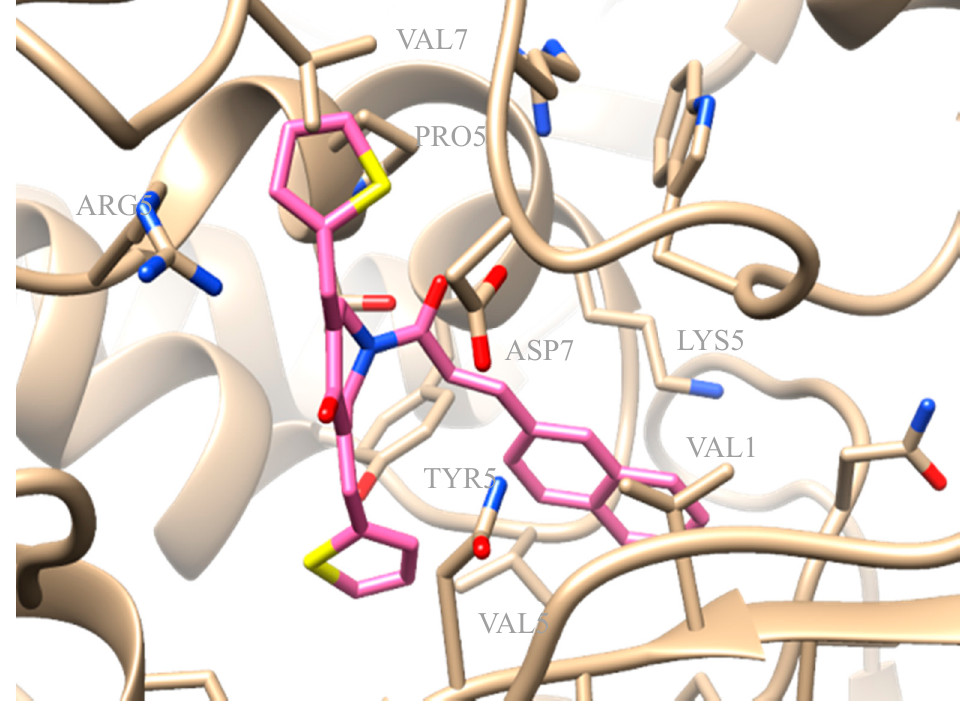
Figure 8. Preferred docking pose of 3e (depicted in pink) bound to soybean lipoxygenase (LOX-1).